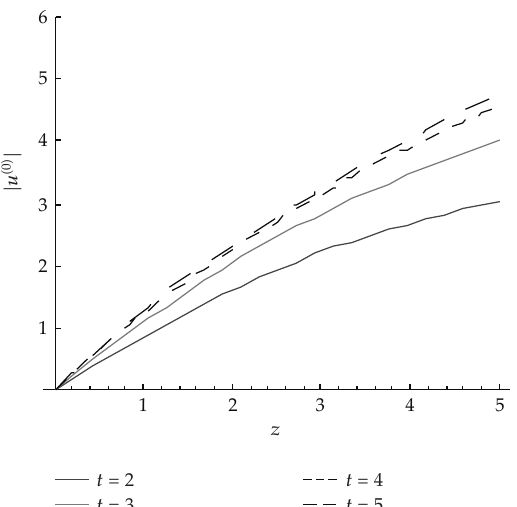
Figure 9: The zero-order approximation | u (cid:3) 0 (cid:4) | at α (cid:8) 1, T (cid:8) 10, γ (cid:8) 02 for di ff erent values of t , considering only one term in the series (cid:3) M (cid:8) 1 (cid:4)